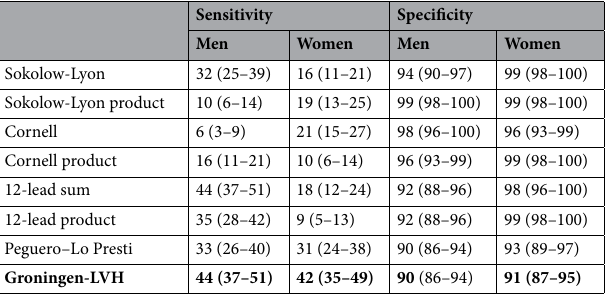
Table 7). For women, the model with best prediction for LVH was: